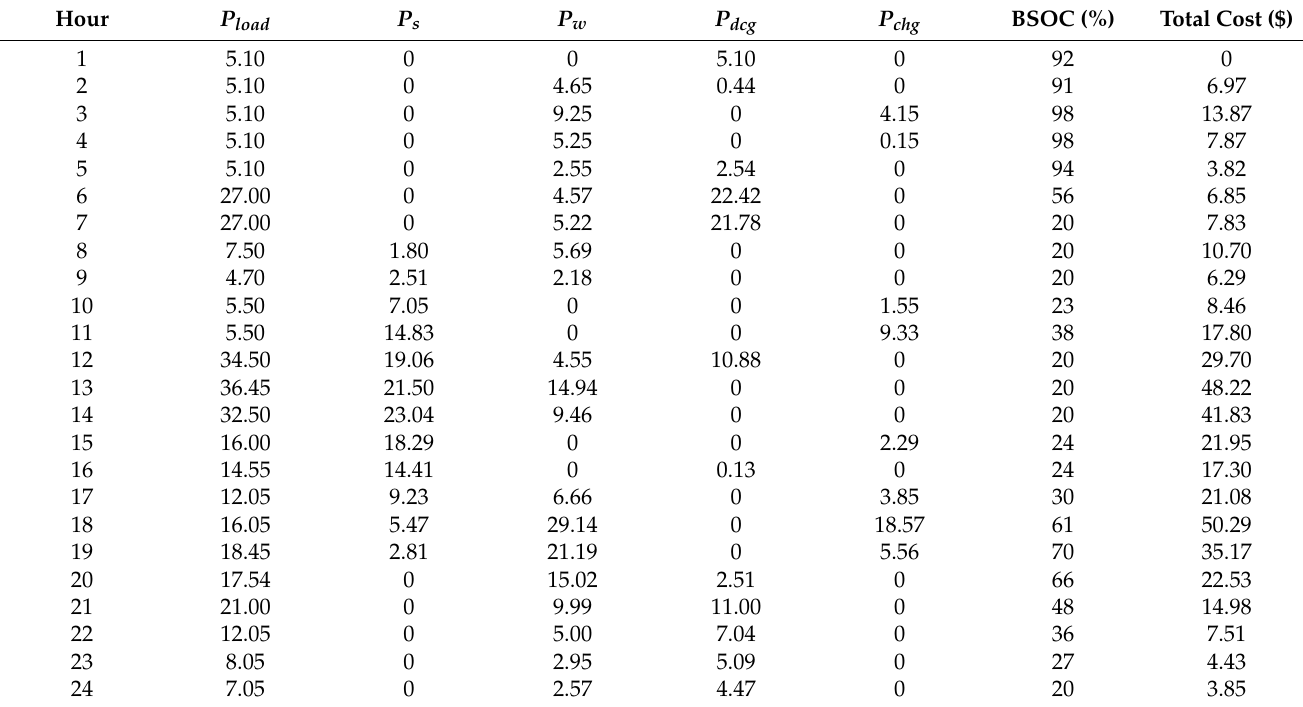
Table 8. Power contribution from each source and total